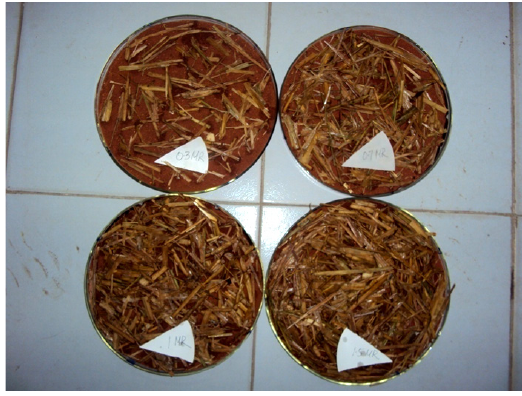
Figure 1 Sample trays containing soil+ rice residue